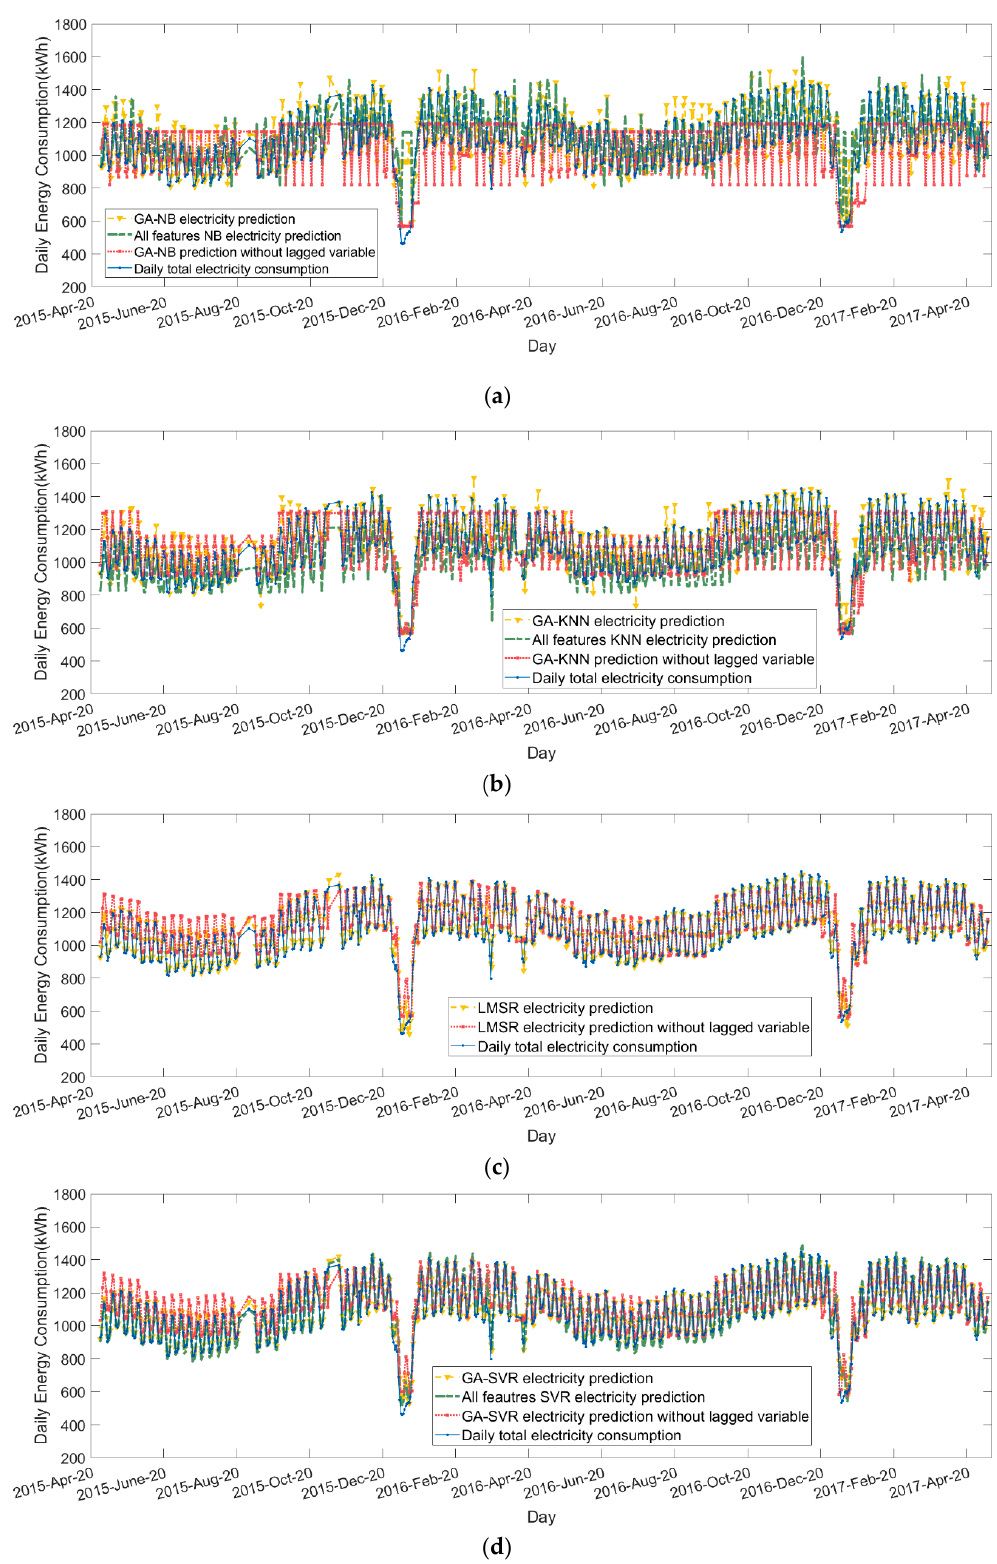
Figure 7. ML modelled electricity performance (Apr 2015–Apr 2017): ( a ) GA-NB electricity model; ( b ) GA-KNN electricity model; ( c ) LMSR electricity model; and, ( d ) GA-SVR electricity model.